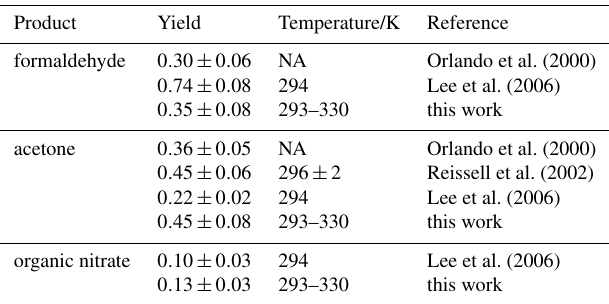
Table 5. Products yields from the reaction of myrcene with OH. NA